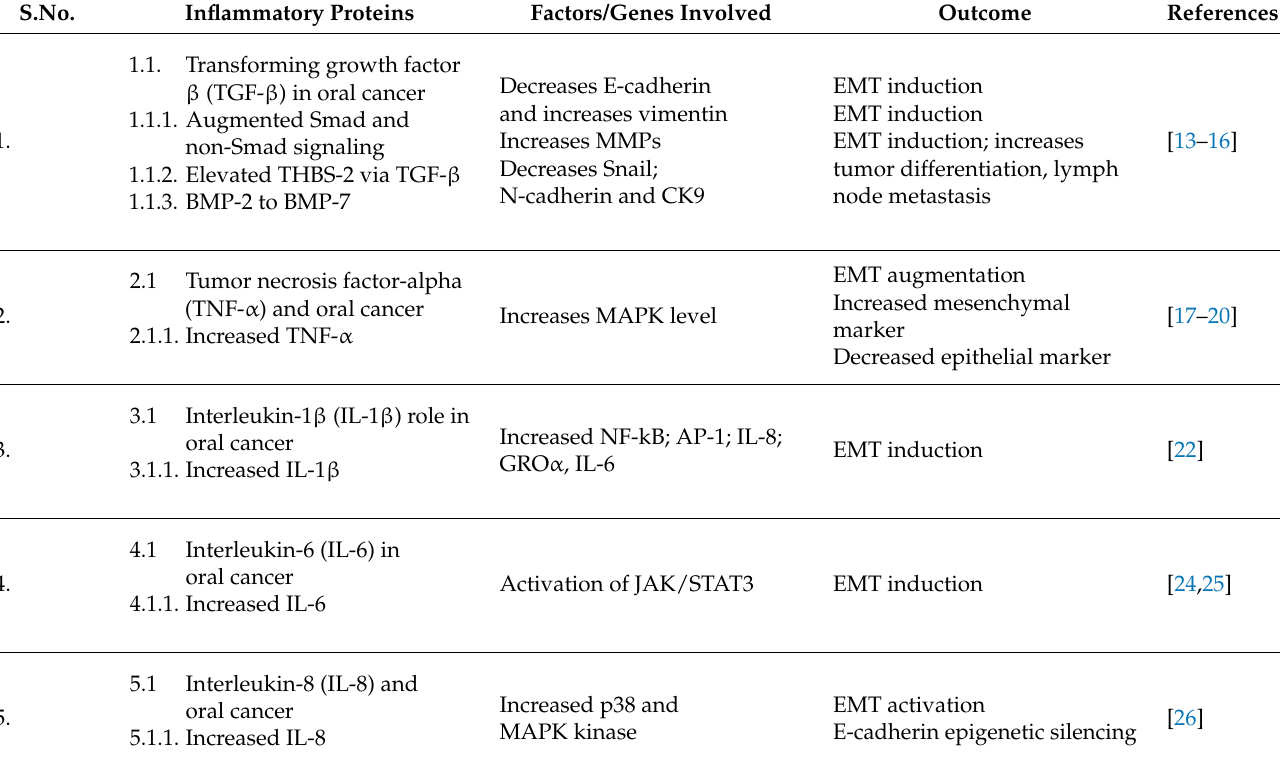
Table 1. Role of Inflammatory proteins which influence EMT in oral cancer